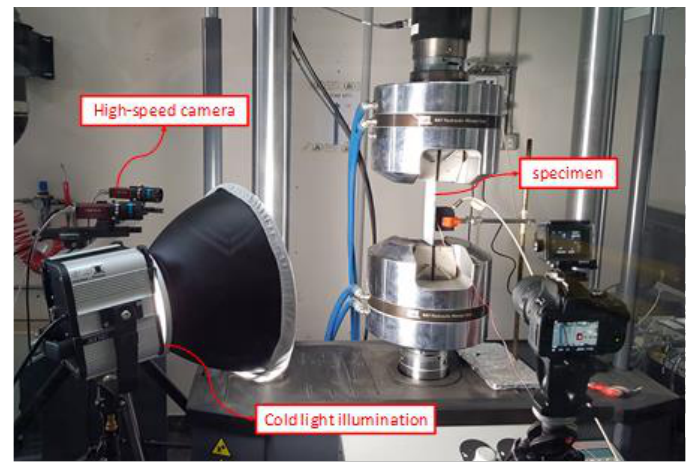
Figure 9. Digital Image Correlation rig.